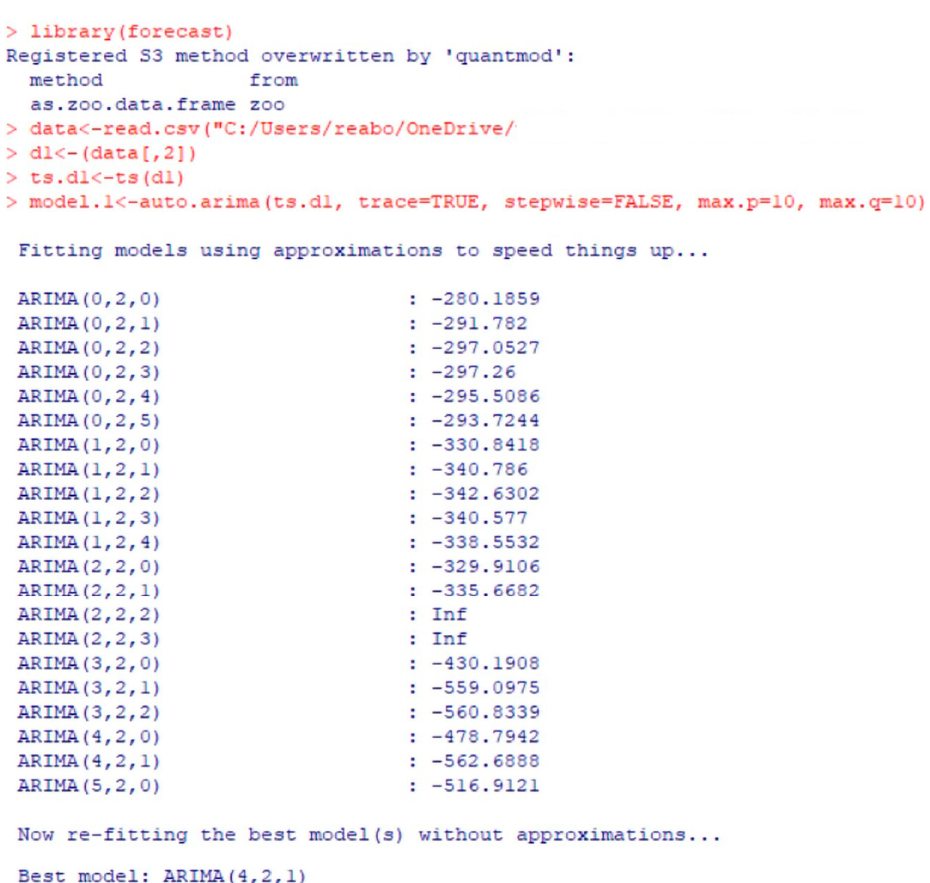
Figure 6. Fitting results of the ARIMA model.